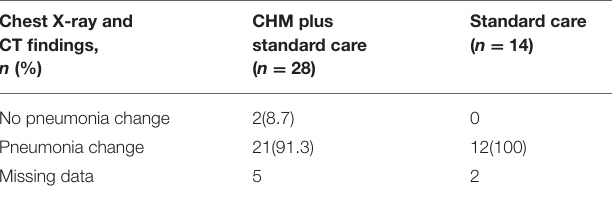
Chest X-ray and CT